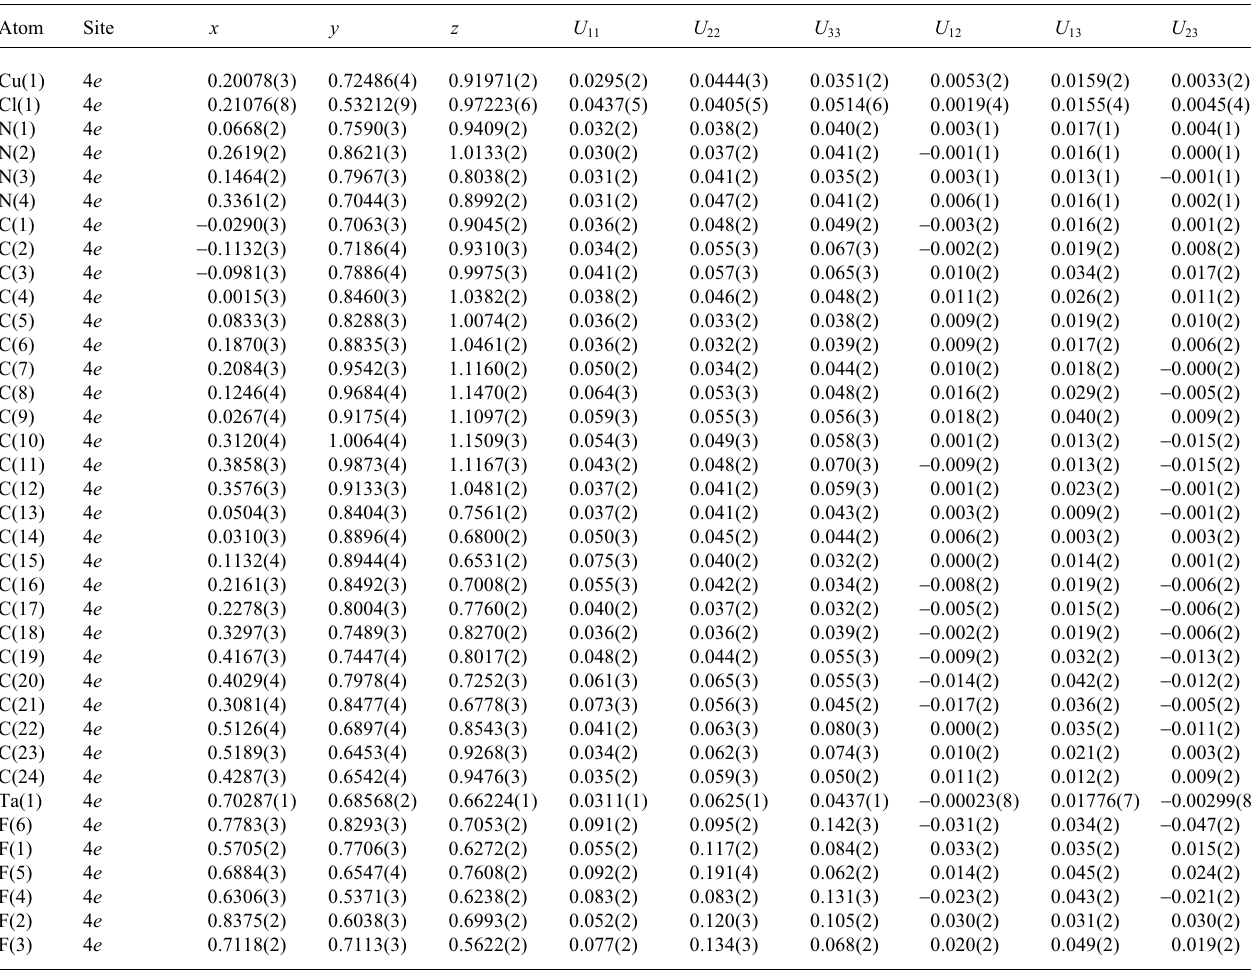
Table 3. Atomic coordinates and displacement parameters (in Å 2 )